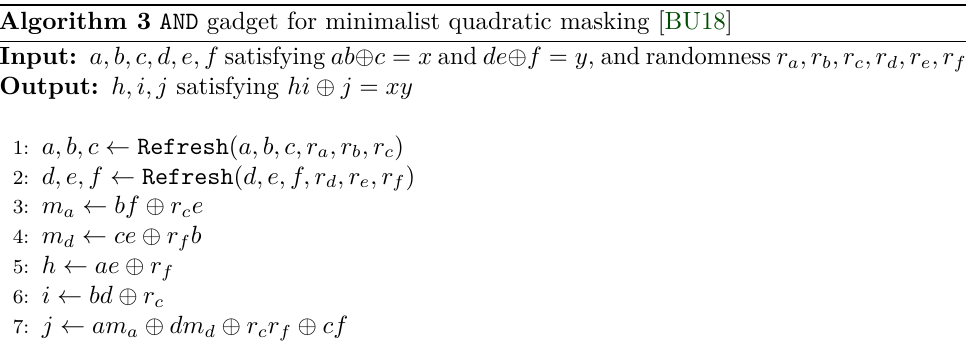
Algorithm 3 AND gadget for minimalist quadratic masking